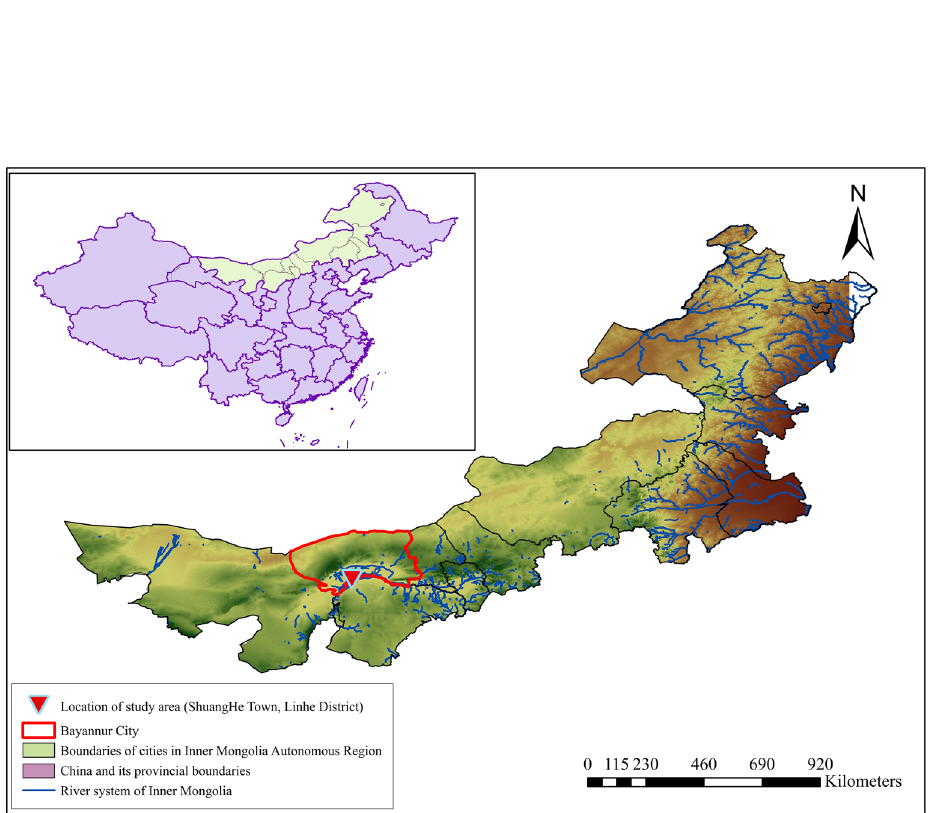
Figure 2. The location of the study